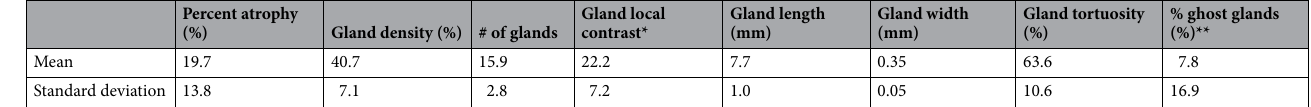
Table 2. Means and standard deviations of morphological features. *Measured in pixel intensity of the meibography image. The lowest intensity the sensor could detect was 0 and the highest was 255. **For the percentage of ghost glands prediction, a binary classification was used (= 0, >